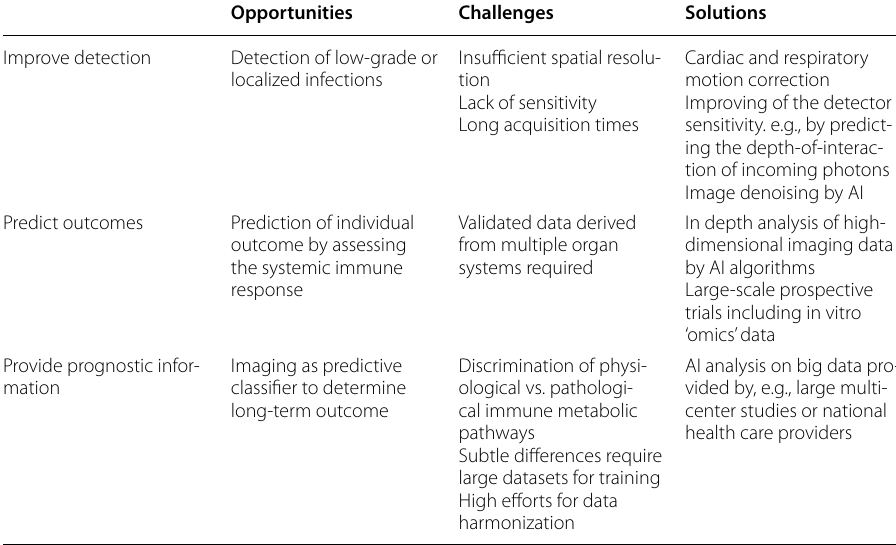
Table 1 Key elements for the future: opportunities, challenges and solutions of AI in infection and inflammation molecular